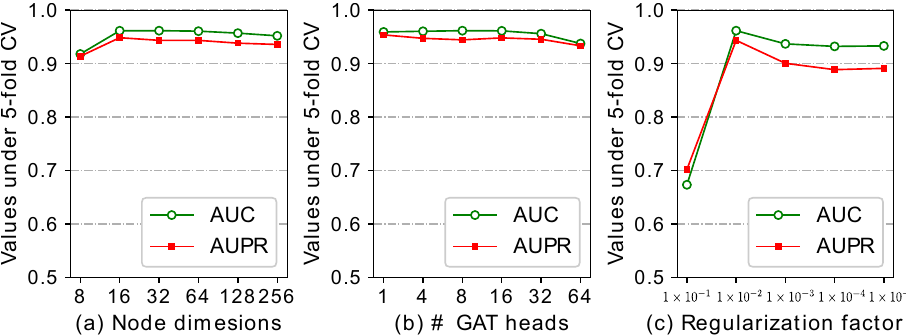
Figure 4. The comparison results of different parameter values based on CircR2Disease